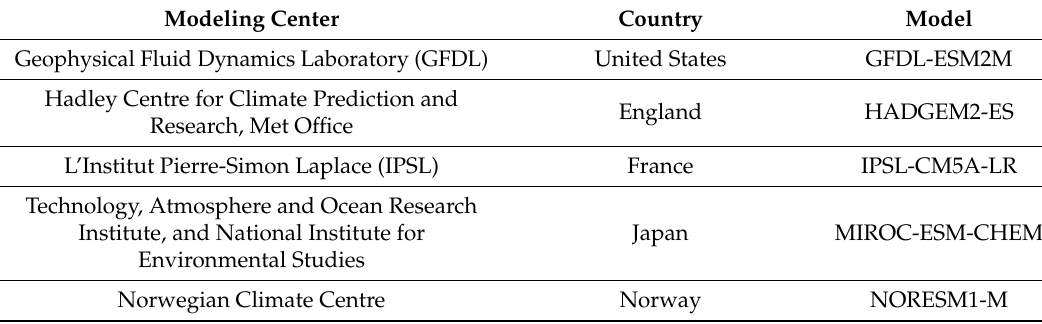
Table 3. Information on the five general circulation models (GCMs) used in this study provided by